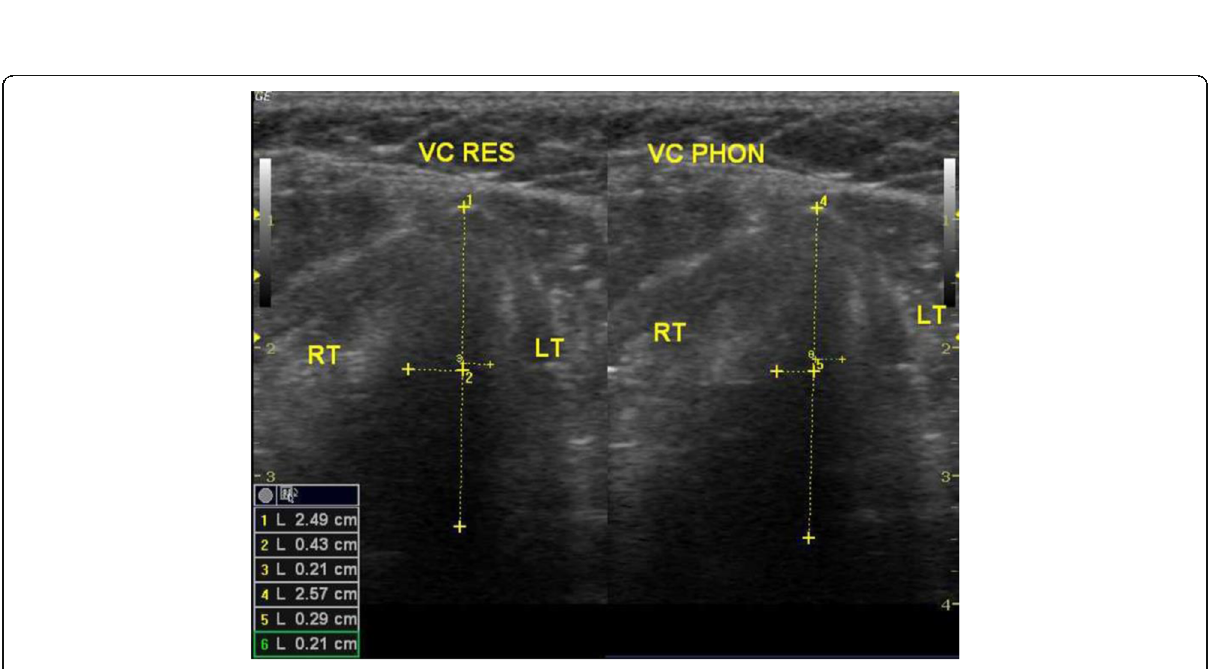
Fig. 4 An ultrasound photo assessing vocal cord mobility in a patient with VC paralysis (adducted type) by drawing imaginary perpendicular line from the junction between both thyroid cartilage anteriorly where distance 2 (0.43 mm) and 5 (0.29) represent contribution of the right VC in respiratory chink in both respiration and phonation. Where distance 3 (0.21 mm) and 6 (0.21 mm) represent contribution of the right VC in respiratory chink in both respiration and